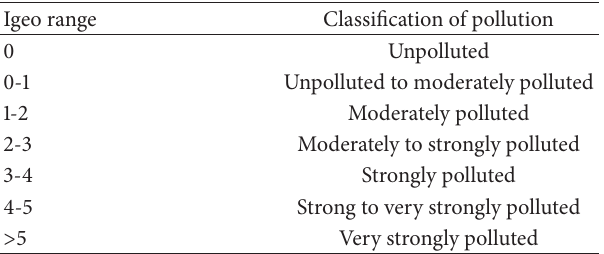
Table 2: Classification of Geoaccumulation index